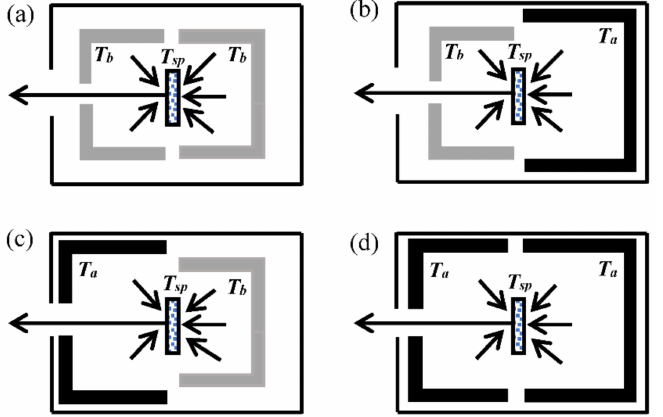
Figure 22. Schematic of temperature and emissivity measurements by the blackbody boundary condition (BBC) method, which ( a – d ) exhibits the different directional-hemispherical transmittance and reflectance)